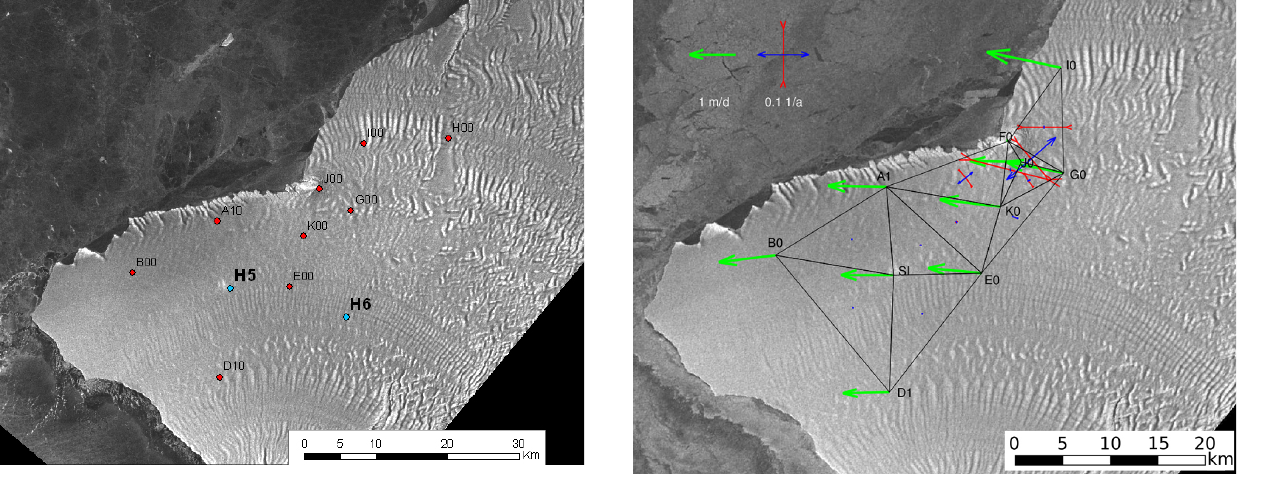
Fig. 13. Strain rates on the BIS during 2011. The green arrows show site movement, the red lines show compression rates and the blue lines show expansion rates. This analysis shows that most of the ice shelf is moving in similar directions at similar rates so there is little strain in the ice. The exception is at the near-stationary McDonald Ice Rumples (site F0), where compression and expansion